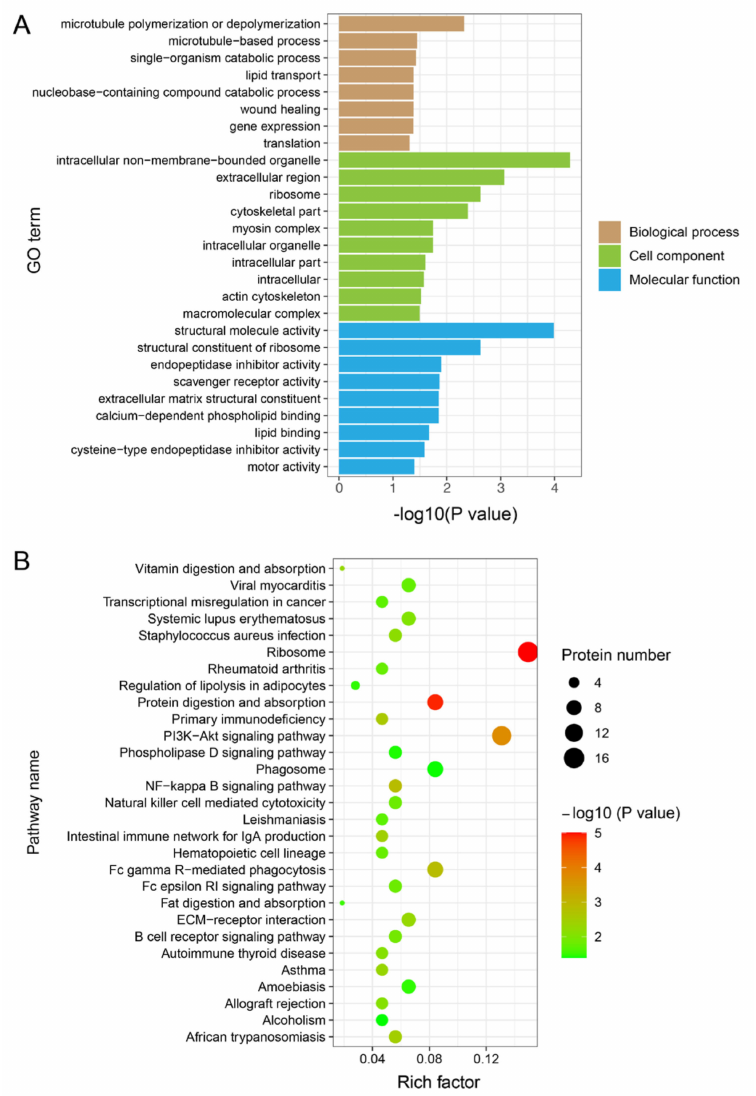
Figure 4. GO and KEGG functional enrichment analyses of the DEPs. ( A ) GO enrichment analysis of DEPs. The X–axis represents the − log10( p value), whereas the name of the GO term is presented on the Y–axis. ( B ) KEGG enrichment analysis of the DEPs. The X–axis displays the rich factor, and the Y–axis represents the pathway name. The number of proteins and the − log10( p value) are indicated by the size and color of the dots,